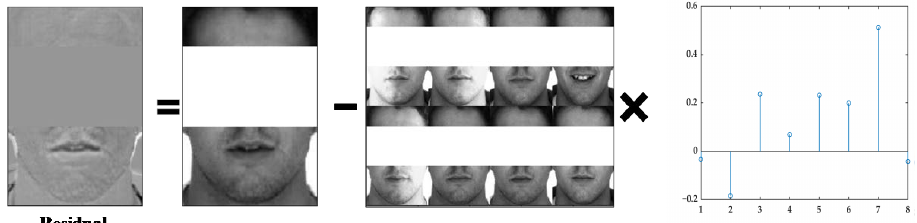
Figure 5. Residual calculation of arrangement scheme h (sunglasses occluding the face). [reprinted with permission from Elsevier [20]. Copyright 2013, Neurocomputing].